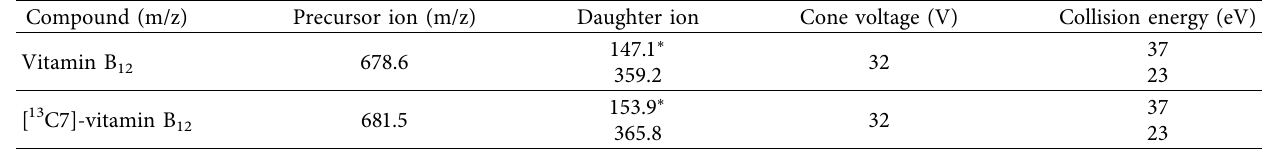
Table 1: LC/MS/MS